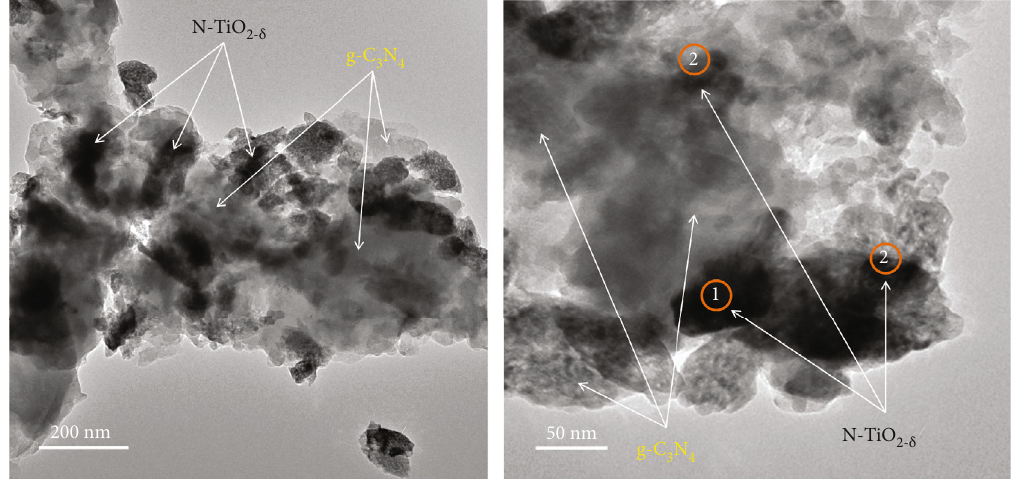
Figure 4: TEM images of